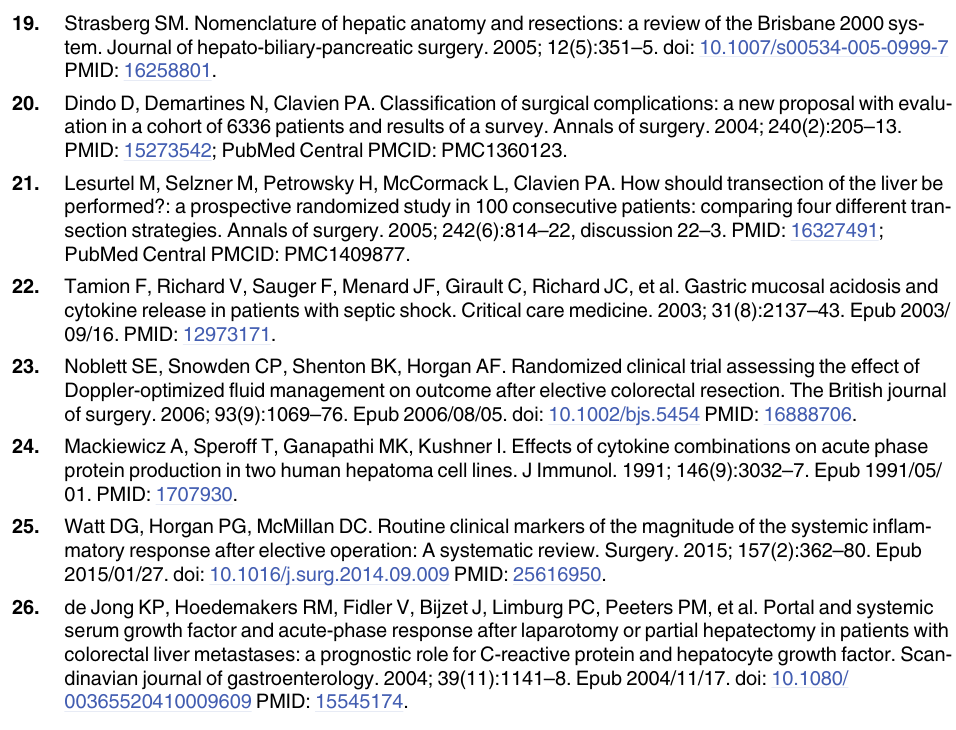
PLOS ONE | DOI:10.1371/journal.pone.0140314 October 9,